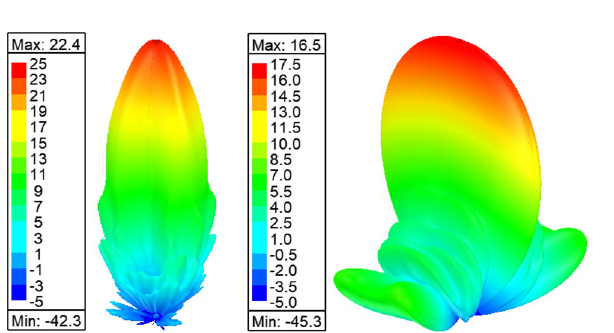
Figure 12. 3D radiation pattern for the semi-ring shape dielectric slabs (left), and rectangular dielectric slabs (right) at 20